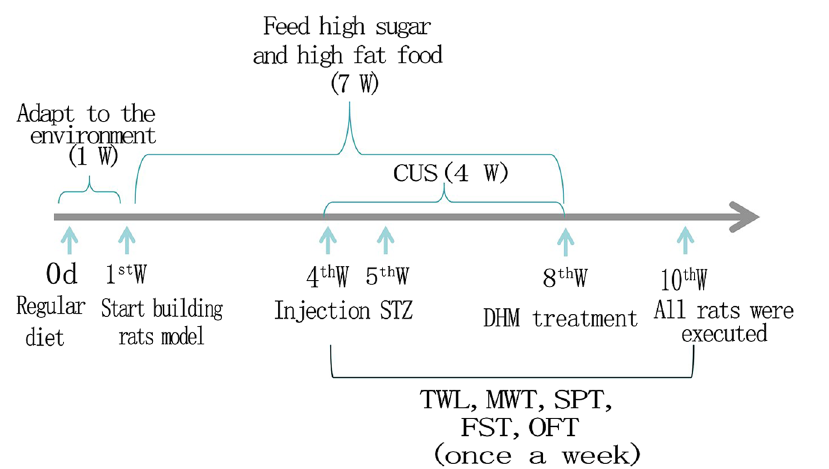
Figure 10. Timeline of the model establishment and sample